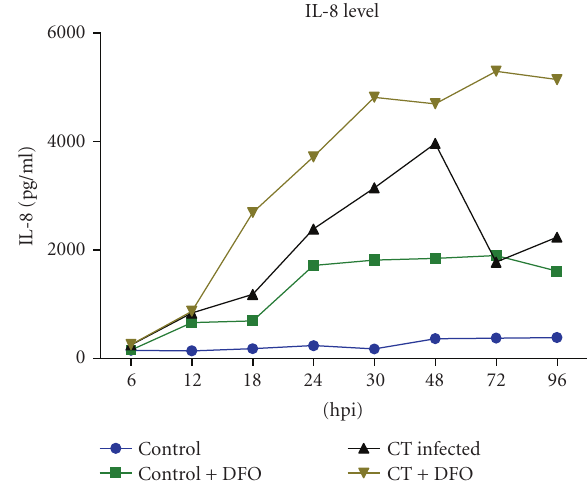
Figure 1: C. trachomatis infected HeLa 229 cells showing signifi- cantly ( P < 0 . 001) increased levels of IL-8 as detected by ELISA in comparison to mock infected